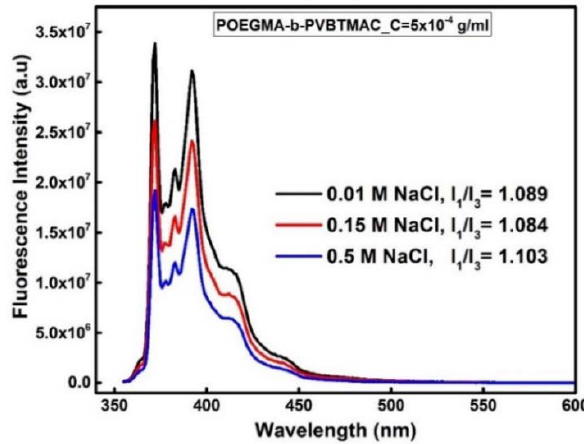
Figure 3. Fluorescence pyrene emission spectra from POEGMA- b -PVBTMAC solutions at different NaCl concentrations.